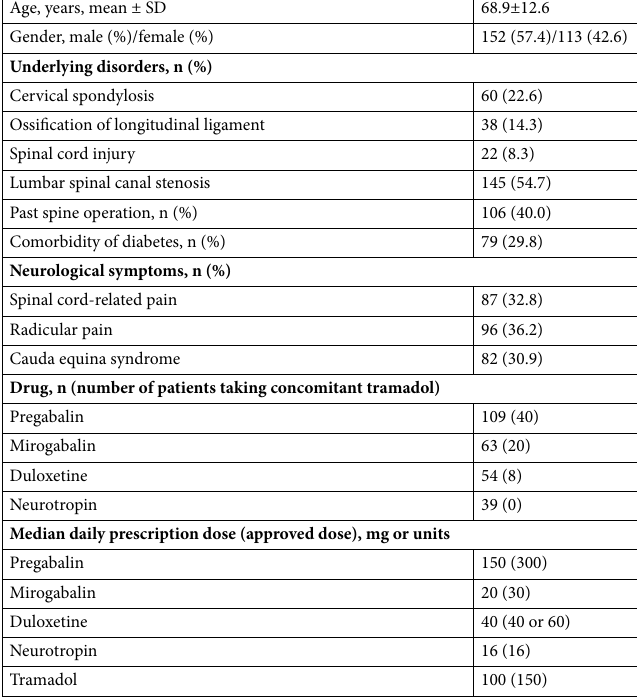
Table 1. Summary data for 265 patients.